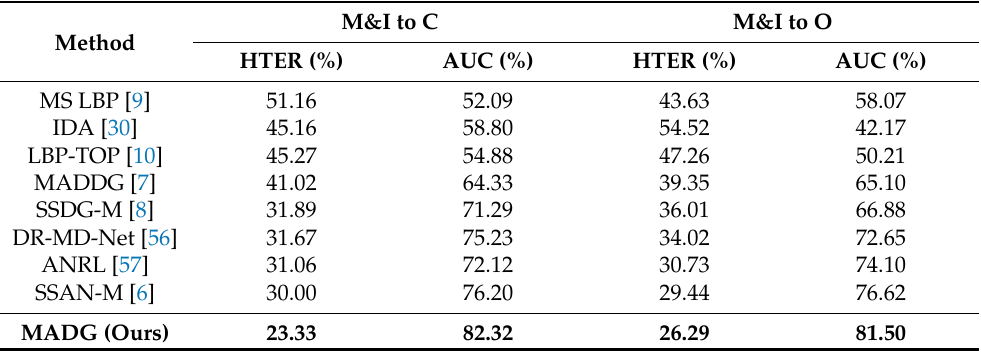
Table 7. Comparison with state-of-the-art methods on limited source domains. The header is the task protocol and the bold represents the optimal result.